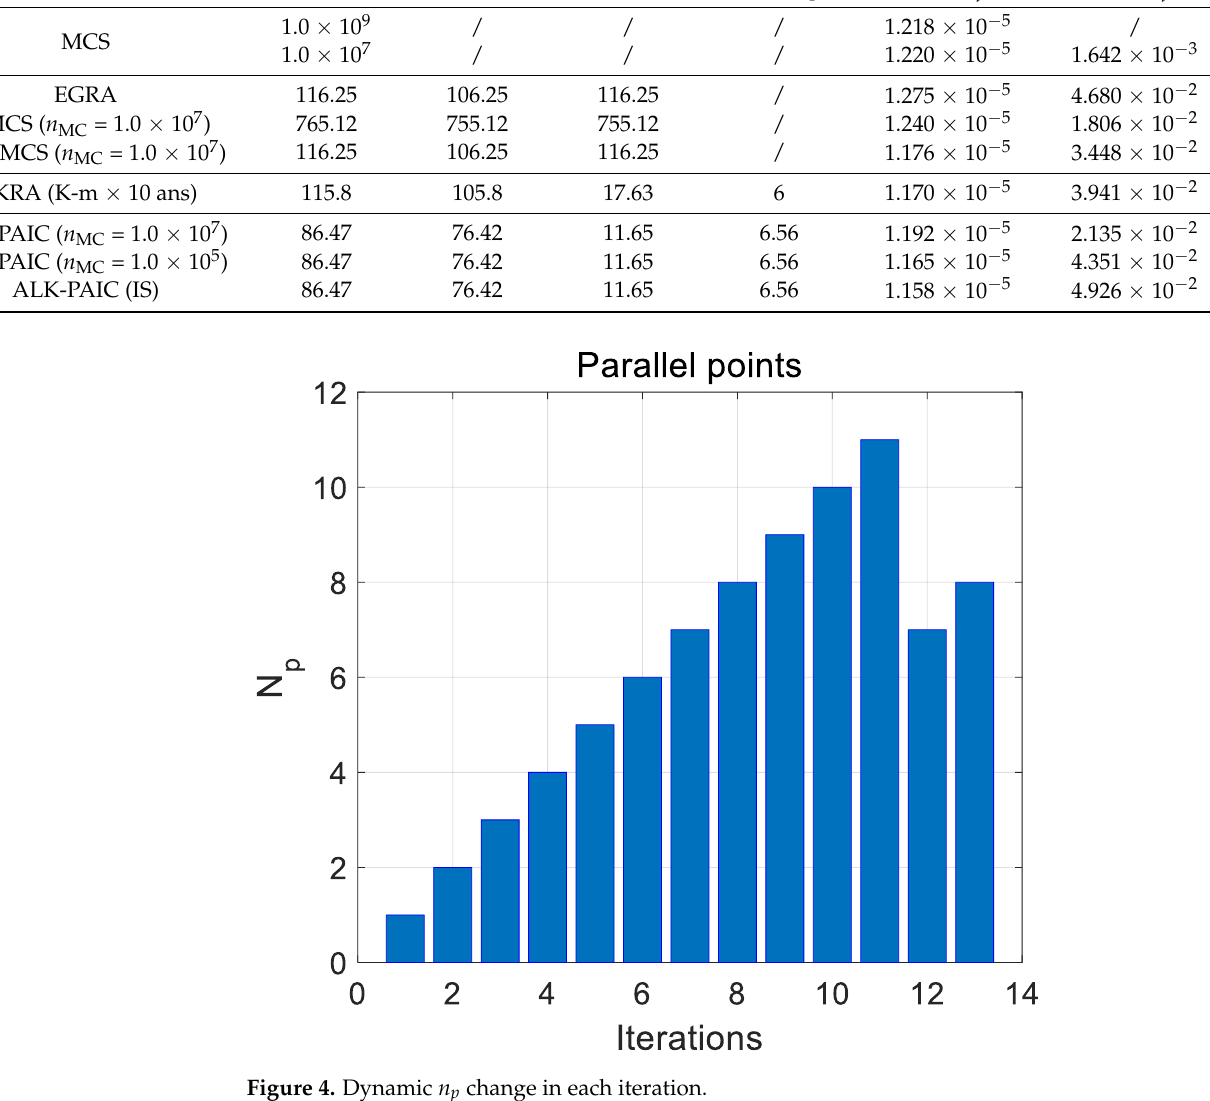
Figure 4. Dynamic n p change in each iteration.